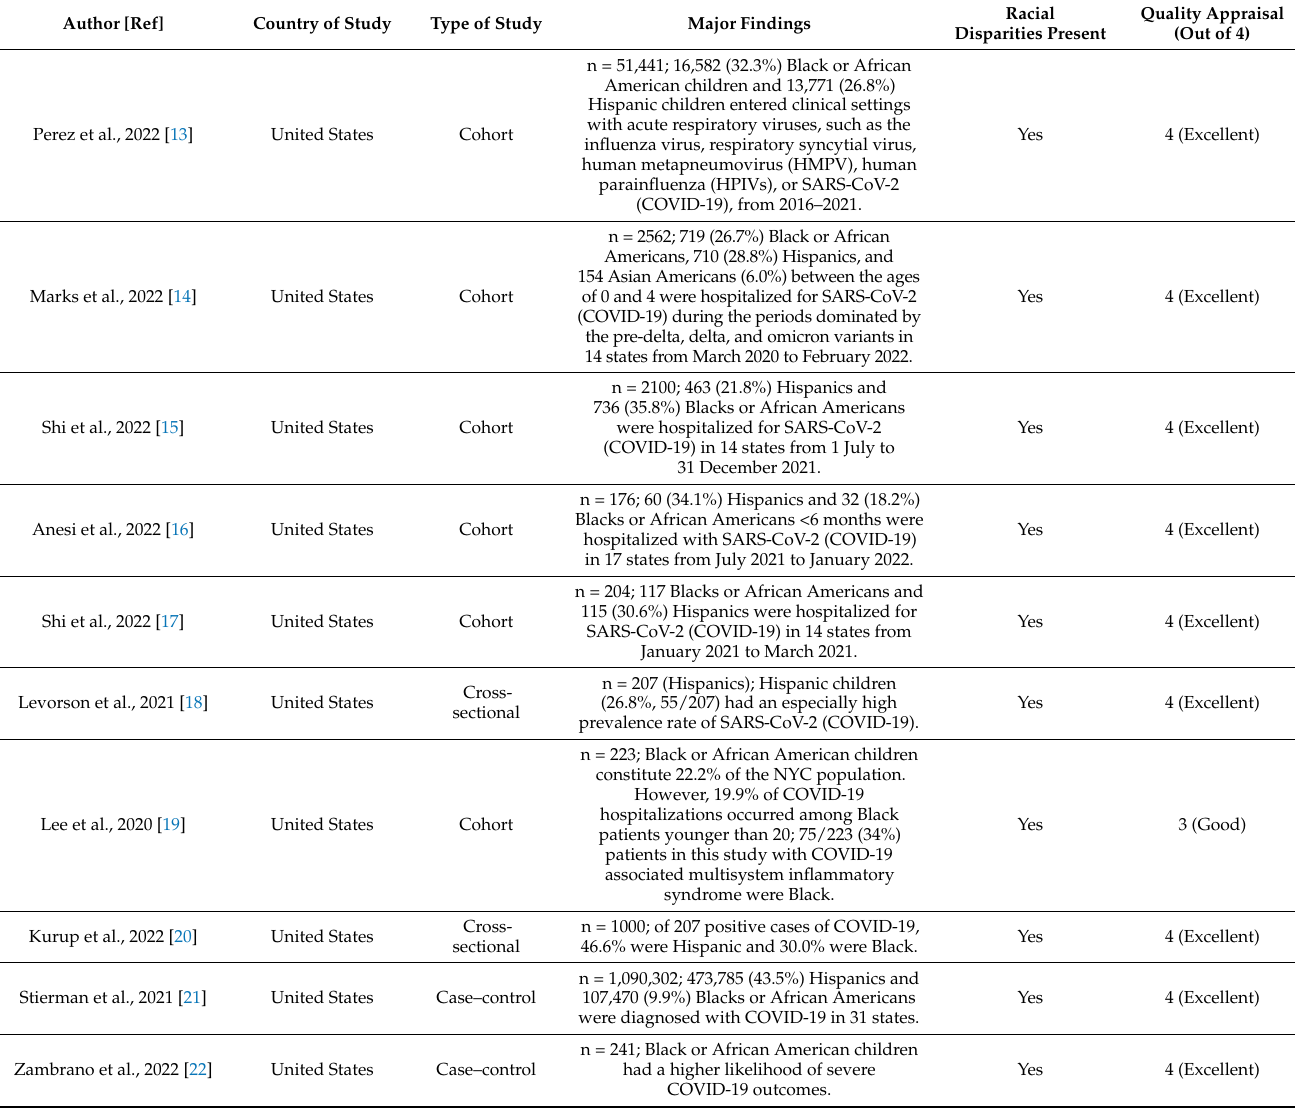
Table 3. Relationship between racial disparities and occurrence of infectious respiratory diseases in